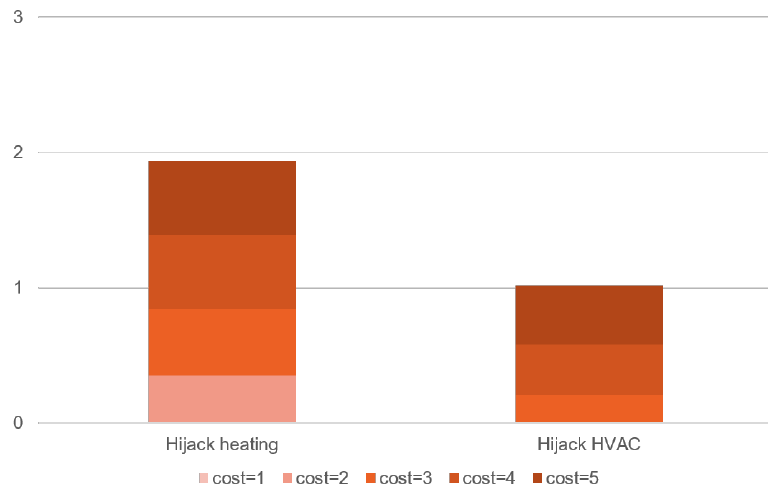
Figure 8. Smart home and HVAC hijack use case results.